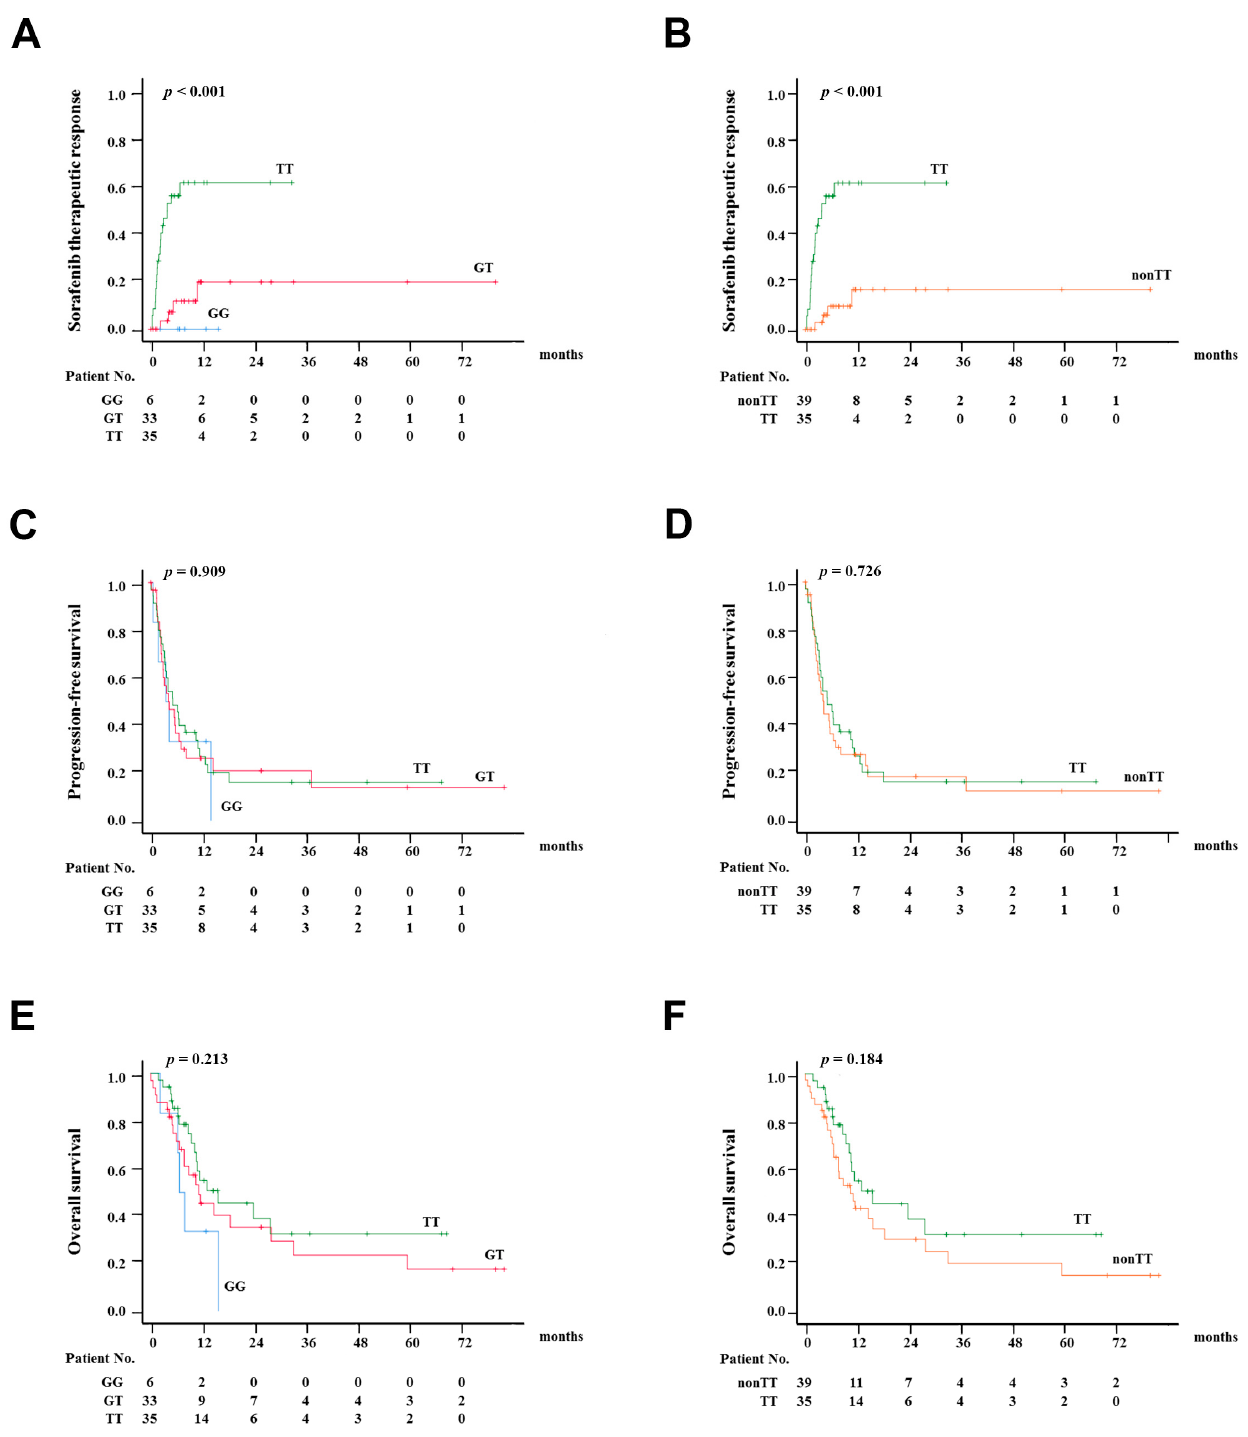
Figure 2. Kaplan–Meier analysis in advanced HCC patients receiving sorafenib therapy. ( A ) Sorafenib therapeutic response (time-to-response) in different rs1010816 genotypes. ( B ) Sorafenib therapeutic response (time-to-response) in rs1010816 “TT” and “non-TT” genotypes. ( C ) Progression-free survival in different rs1010816 genotypes. ( D ) Progression-free survival in rs1010816 “TT” and “non-TT” genotypes. ( E ) Overall survival in different rs1010816 genotypes. ( F ) Overall survival in rs1010816 “TT” and “non-TT” genotypes.